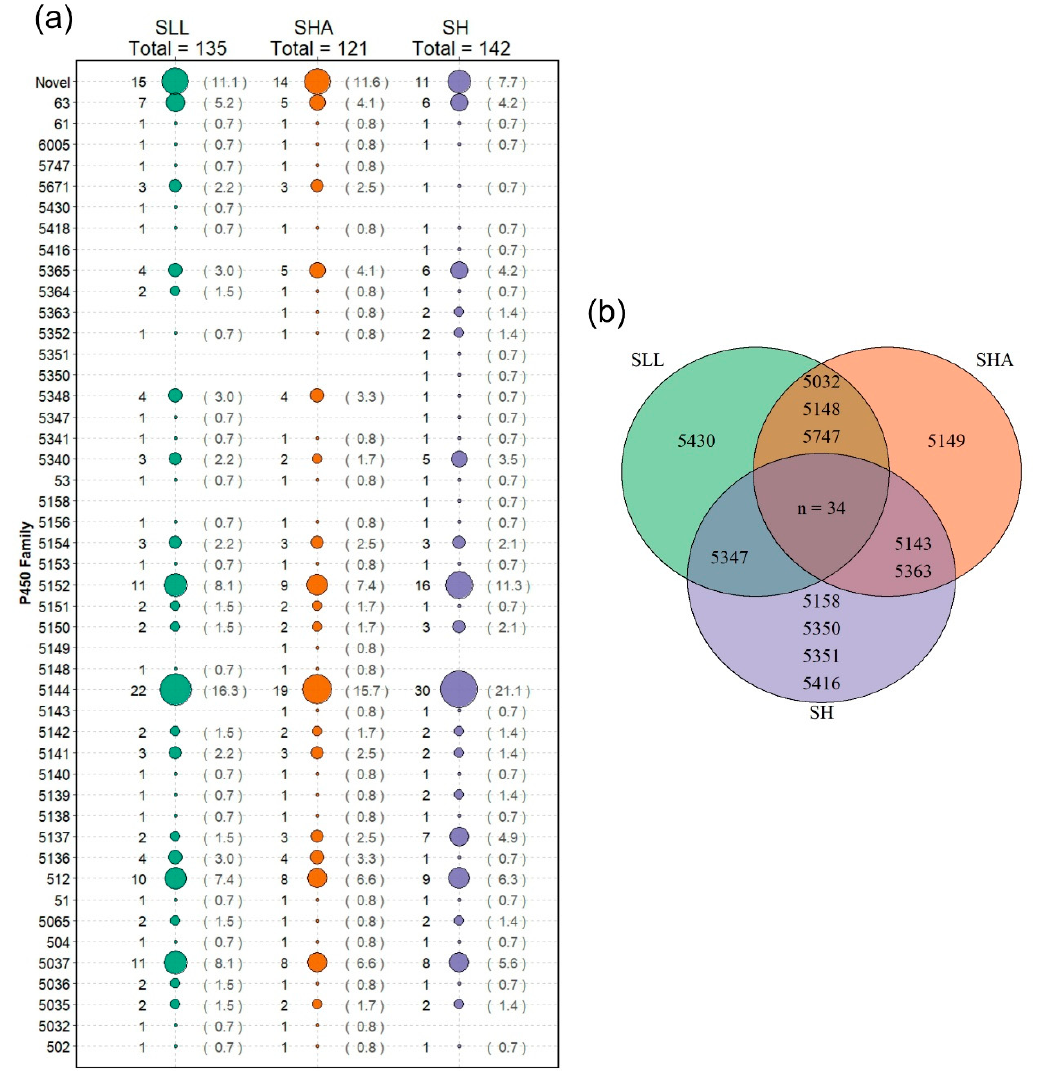
Figure 1. The predicted P450 complement of S. lacrymans var. lacrymans (SLL), S. lacrymans var shastensis (SHA) and S. himantioides (SH). The suggested family assignment is based on identity of amino acid sequences, with putative P450s showing <40% identity to named P450 sequences described as ‘novel’. ( a ) Bubble size is relative to the number of P450 proteins assigned to that family. For each strain, the number of P450 proteins assigned to the family is on the left of the bubble and percentage of the total P450 count for that strain is given on the right. ( b ) Distribution of P450 families between the three strains. The 34 families shared between all three strains are as follows: CYP51, 53, 61, 63, 504, 512, 5035–5037, 5065, 5136–5142, 5144, 5150–5154, 5156, 5340, 5341, 5348, 5352, 5364, 5365, 5148, 5671, and 6005.